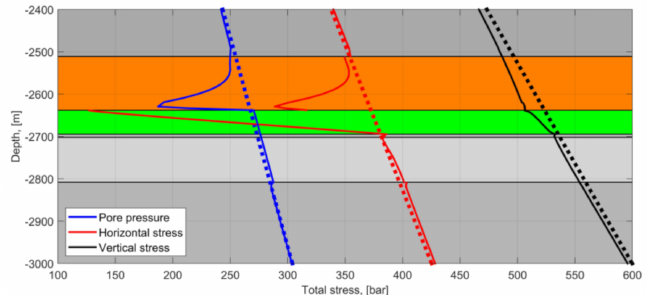
Figure 10. Vertical profiles of pore pressure (blue), total horizontal stress (red) and total vertical stress (black) for initial state (thick dotted lines) and after 50 years (solid lines). Injection reservoir (Cook Fm.) is green and caprock (Drake Fm.) is